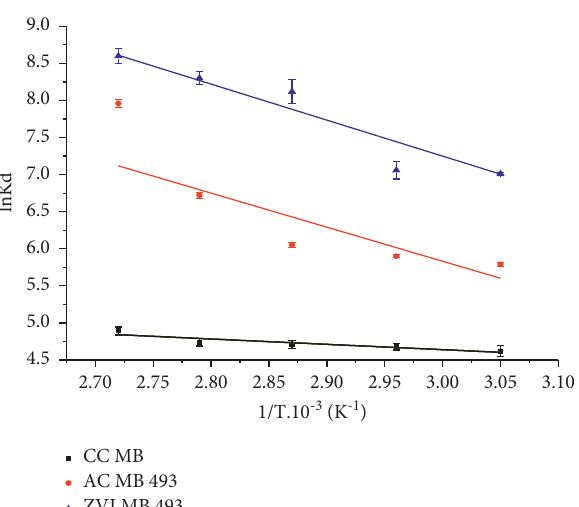
Figure 16: Adsorption isosteres used to determine the isosteric heat of carotenes onto CC MB, AC MB 493, and ZVI MB 493 at 95 °